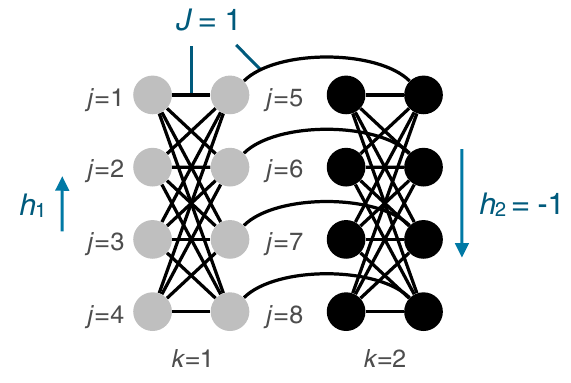
FIG. 2. A pair of weak-strong clusters, consisting of 16 qubits in two unit cells of the Chimera graph. All qubits are ferromag- netically coupled and evolve as part of two distinct qubit clusters.